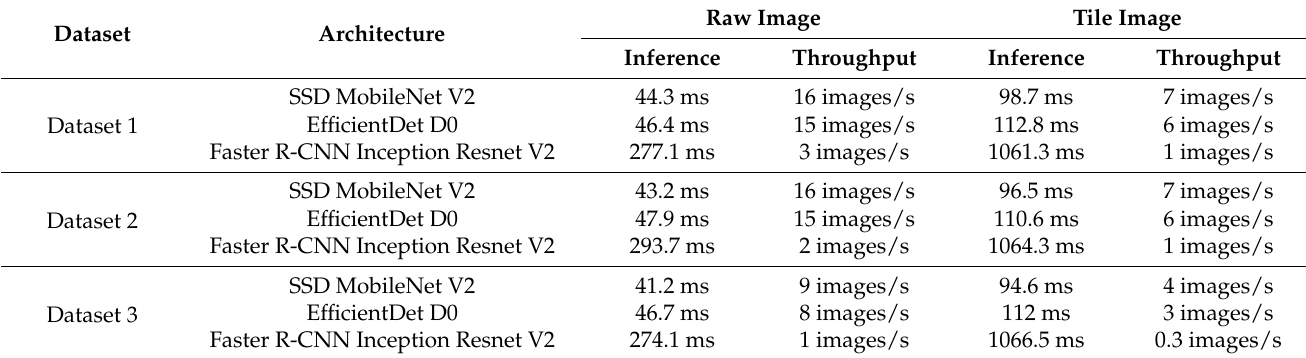
Table 10. Evaluated model inferences on the test